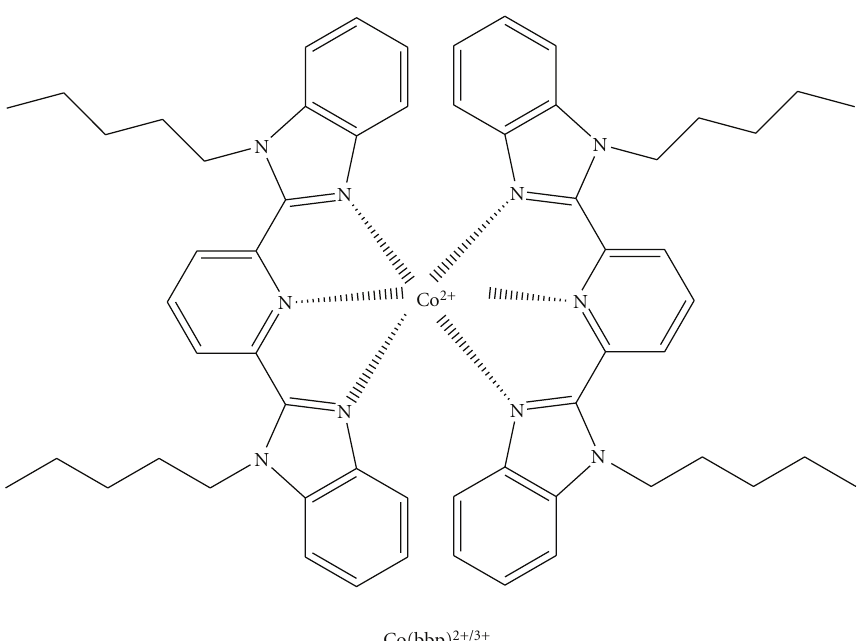
Figure 10: Molecular structure of redox couple replacing